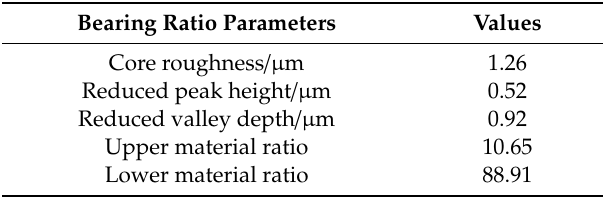
Table 1. Bearing ratio parameters of plateau honed cast-iron